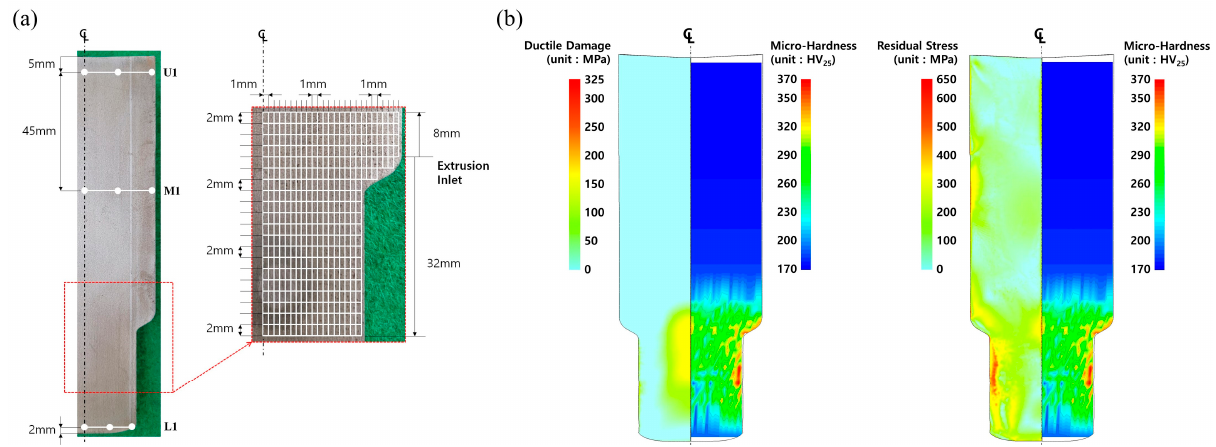
Figure 17. Vickers micro-hardness distribution of preform fabricated by cold forward extrusion: ( a ) detailed grid structures for measuring micro-hardness; ( b ) comparison of Vickers micro-hardness distribution between ductile damage and residual stress.